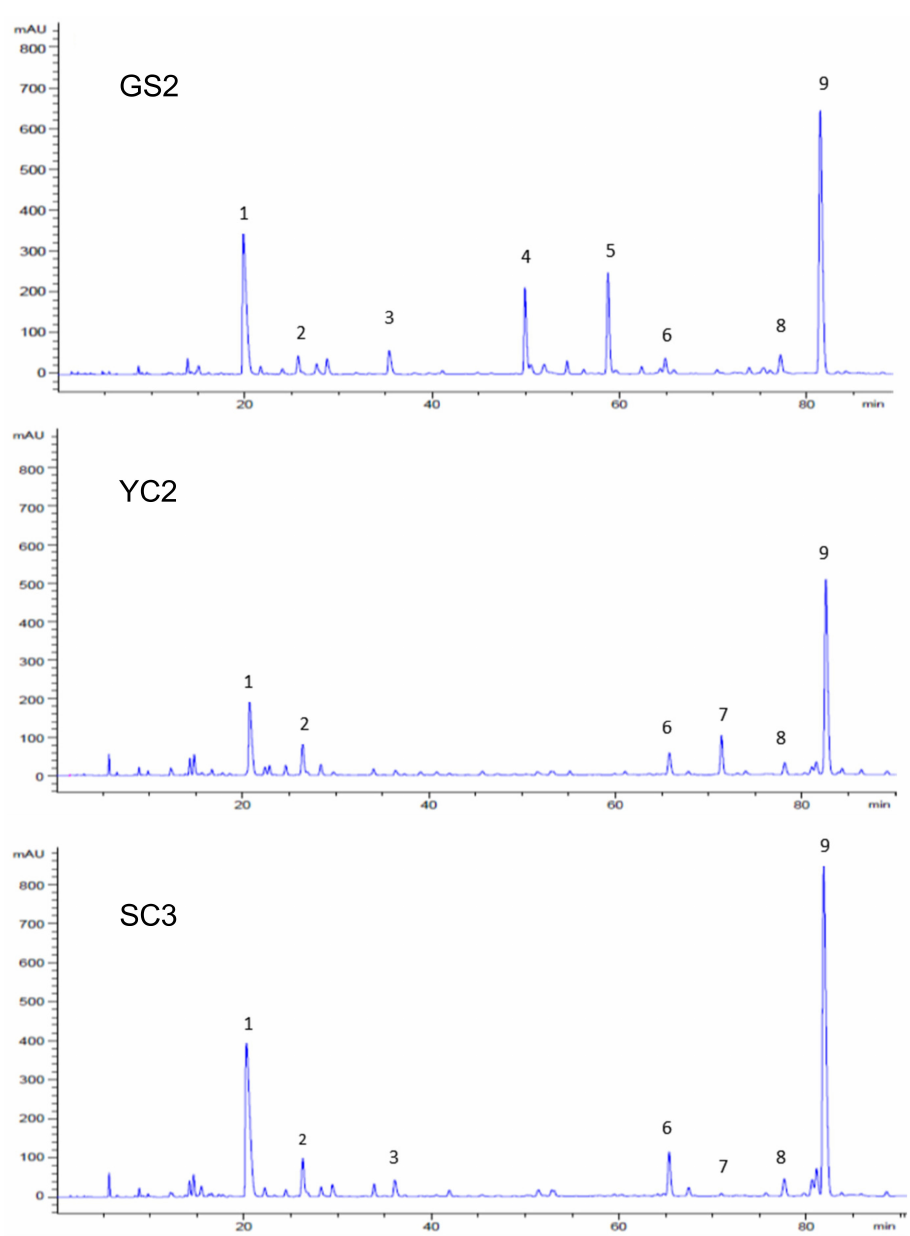
Figure 2. RP-HPLC chromatograms of three representative GHL extract samples. As in Table 1, a set of marker compounds to evaluate regional difference among the GHL extracts was summarized. Among the selected markers, seven compounds were iden- tified in our previously study [20]. Two marker compounds, glucopyranosyl rosmarinic acid (salviaflaside) and dihydroferulic acid 4- O -glucuronide, were newly identified by the high resolution ESI-MS and tandem mass spectrometry in the present study. Glucopyra- nosyl rosmarinic acid (marker compound 7, Rt = 71 min) was detected at m/z 521.1284 as [M-H] - in the negative ion mode. The measured mass value displayed a mass accuracy of − 2.1 ppm from the theoretical mass value m/z 521.1295 obtained from the expected molecular formula C 24 H 26 O 13